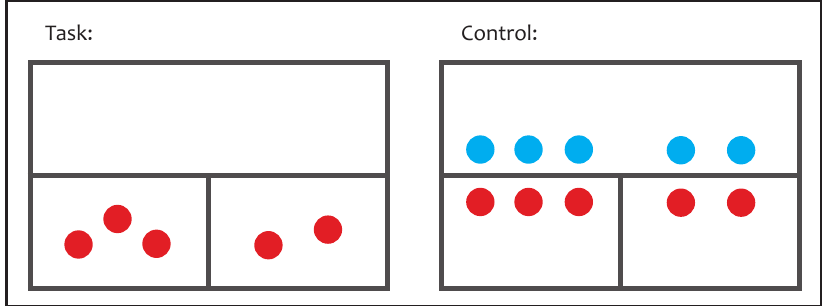
Figure 4: Part + part – producing the whole with